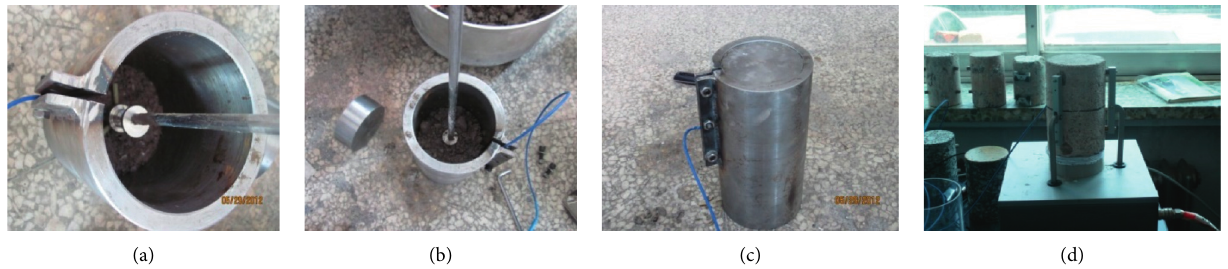
Figure 3: Cylinder-specimen fabrication procedure. (a) Sensor positioning; (b) mixture filling; (c) after molding; (d) LVDT holder